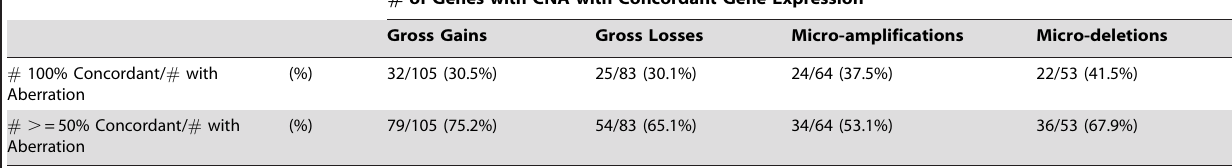
Table 2. Analysis of Concordant Expression by Aberration Type.